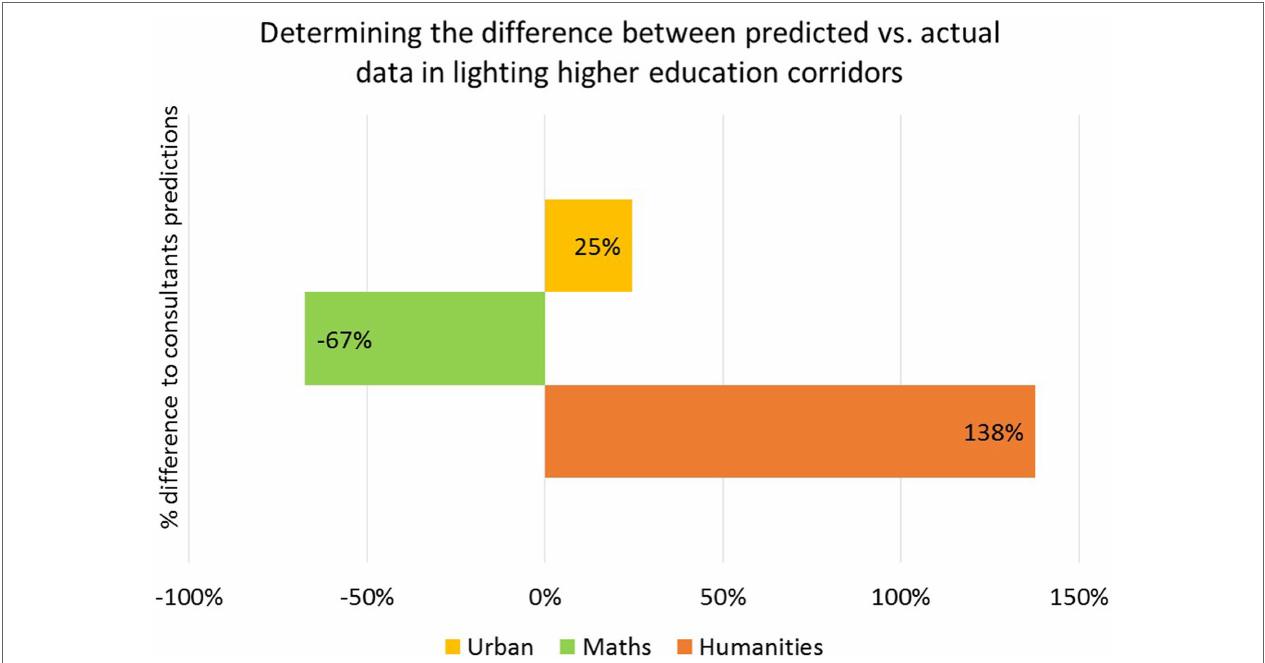
FigUre 13 | Determining the difference between predicted vs. actual data in lighting higher education